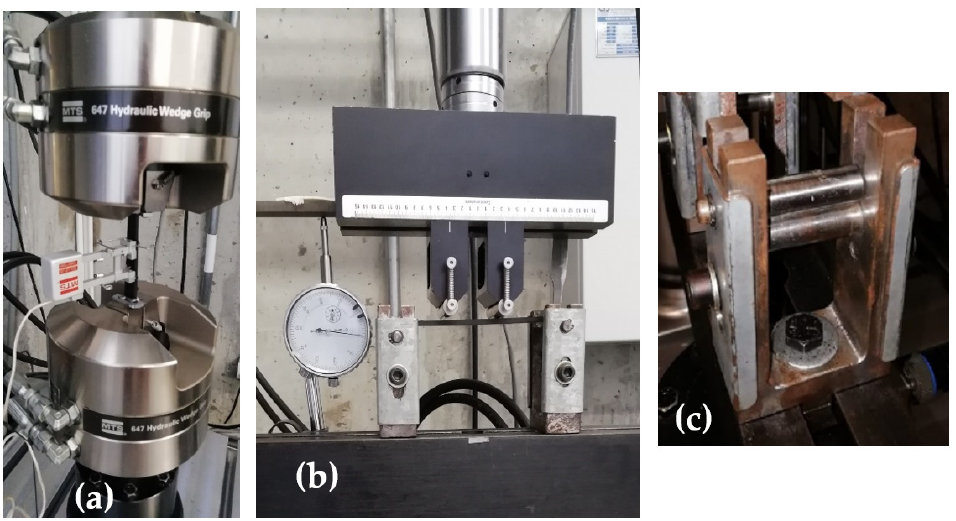
Figure 3. Specimens set up in the universal testing machine MTS 370.02, ( a ) tension test with axial extensometer MTS 632.12f, ( b ) static flexural test with a dial gauge, ( c ) side view of in-house built grips showing bidirectional support.